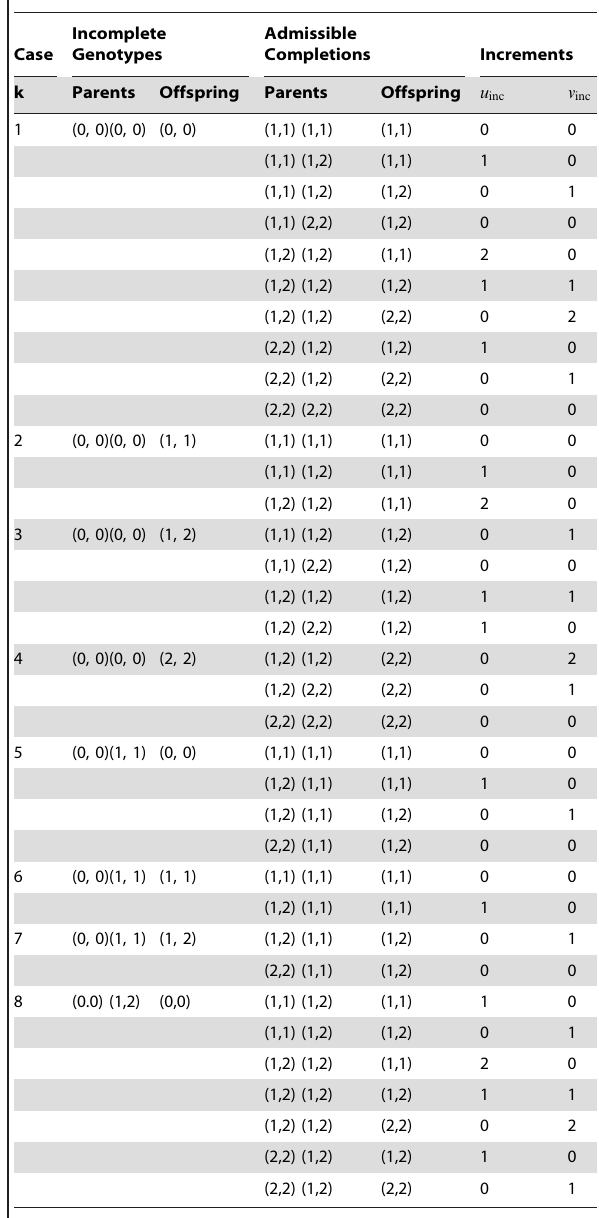
Table 3. Number of missing cases in a family with one affected offspring.